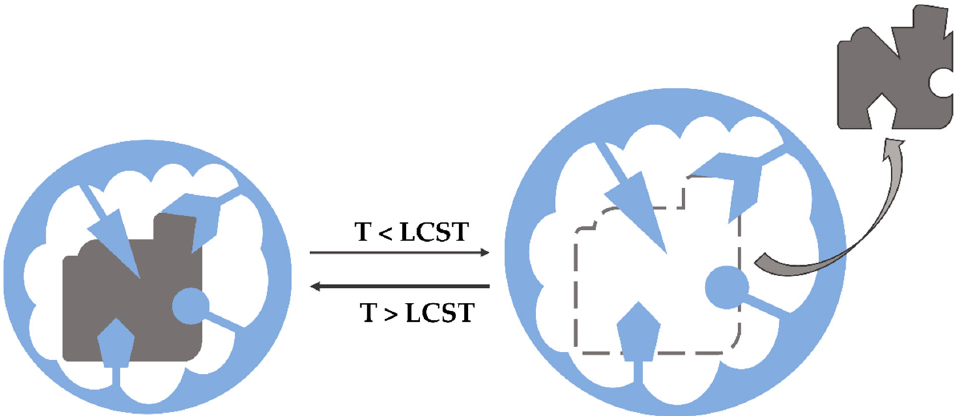
Figure 12. Scheme of the template’s removal mechanism from thermo-responsive MIPs .